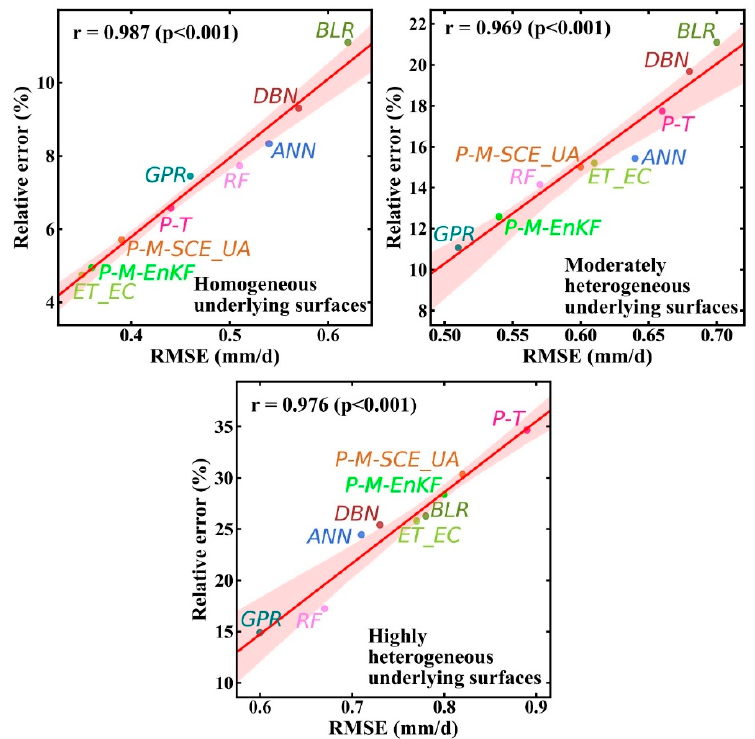
Figure 9. Comparison of relative error derived from the TCH method and RMSE derived from the comparison among LAS measurements, ET_EC, and eight upscaling methods over homogeneous, moderately heterogeneous, and highly heterogeneous underlying surfaces. The r, p, and red shaded area represent correlation coefficient, confidence level, and 95% confidence interval, respectively.